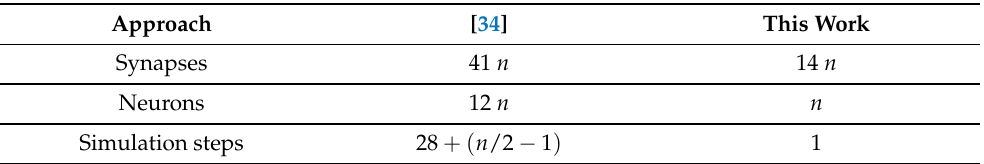
Comparison between the existing neural adder [34] and this work in terms of synapses/neurons and simulation steps. Here, n represents the number of digits of v and u . Adapted from